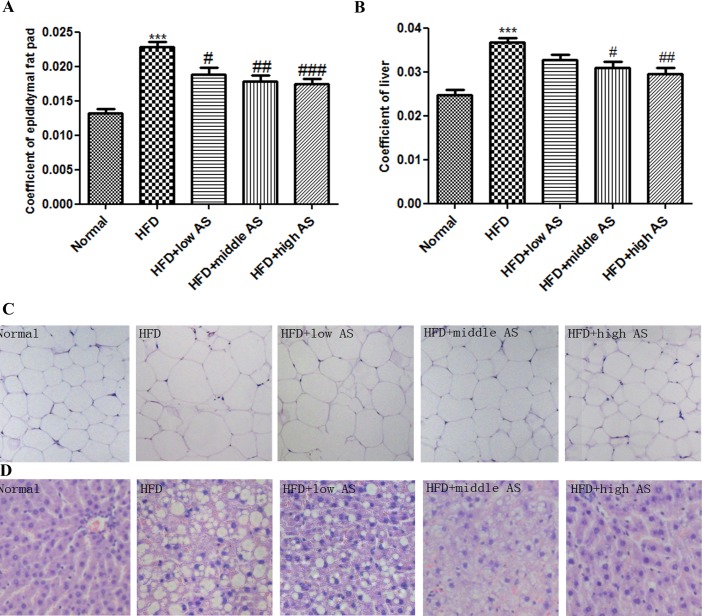
AS extract reduces adipose tissue weight, white adipocyte size and liver accumulation in obese rats.Coefficients of (A) epididymal adipose tissue and (B) liver were calculated after rats had fasted for 12 h at the end of experiment according to the following equation: coefficient = tissue (g/rat)/weight (g/rat). (C) Epididymal adipose tissue and (D) liver were stained with hematoxylin and eosin for histopathological examination. Images were acquired at 400× magnification on a light microscopy. Values are expressed as mean ± SE (n = 6). Significant differences were observed between normal and HFD groups. *P < 0.05, **P < 0.01, ***P < 0.001 vs. normal group; #P < 0.05, ##P < 0.01, ###P < 0.001 vs. model group.